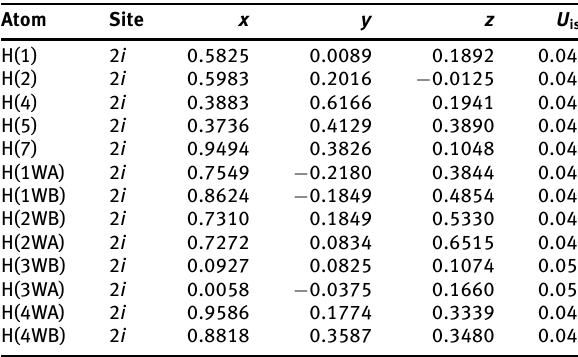
Table 2: Fractional atomic coordinates and isotropic or equivalent isotropic displacement parameters (Å 2